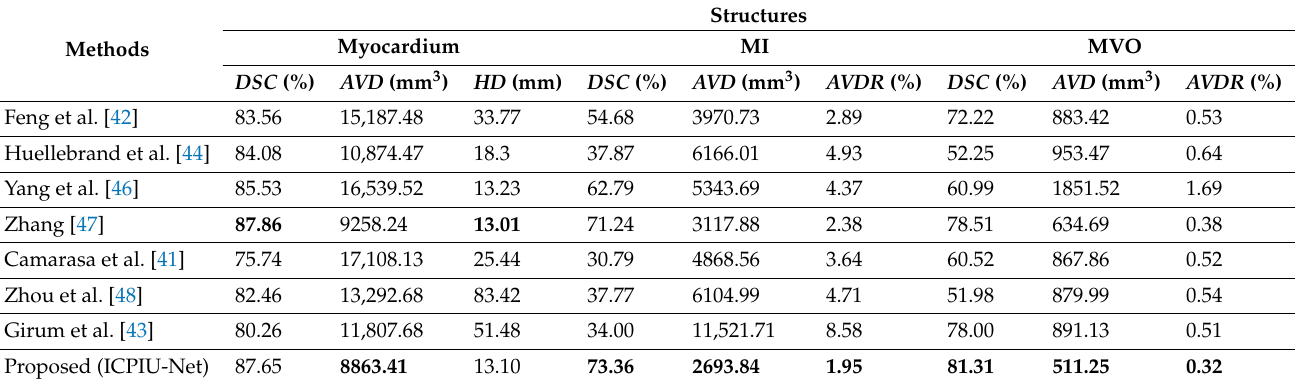
Table 4. Comparative study for EMIDEC myocardial segmentation in LGE-MRI (test leader- board) [62]. Best values are marked in bold font.